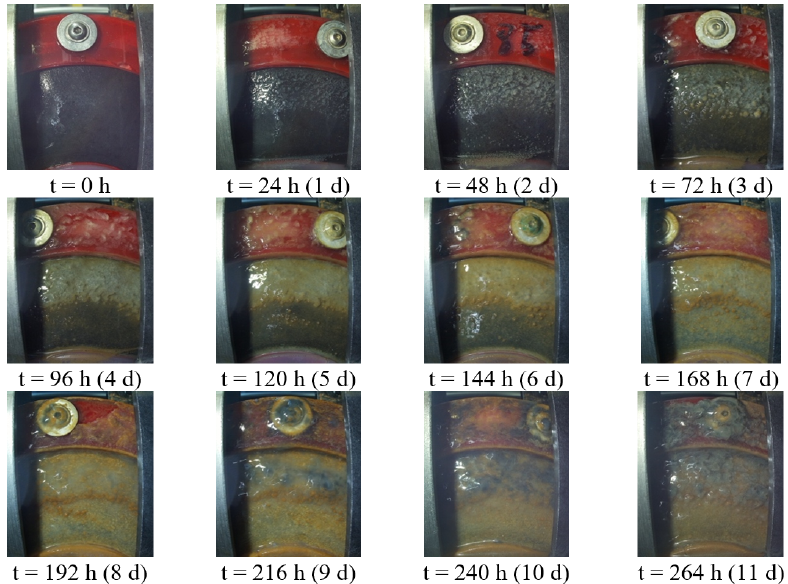
Figure 3. Biofilm development on an untreated cathode during 11 days.